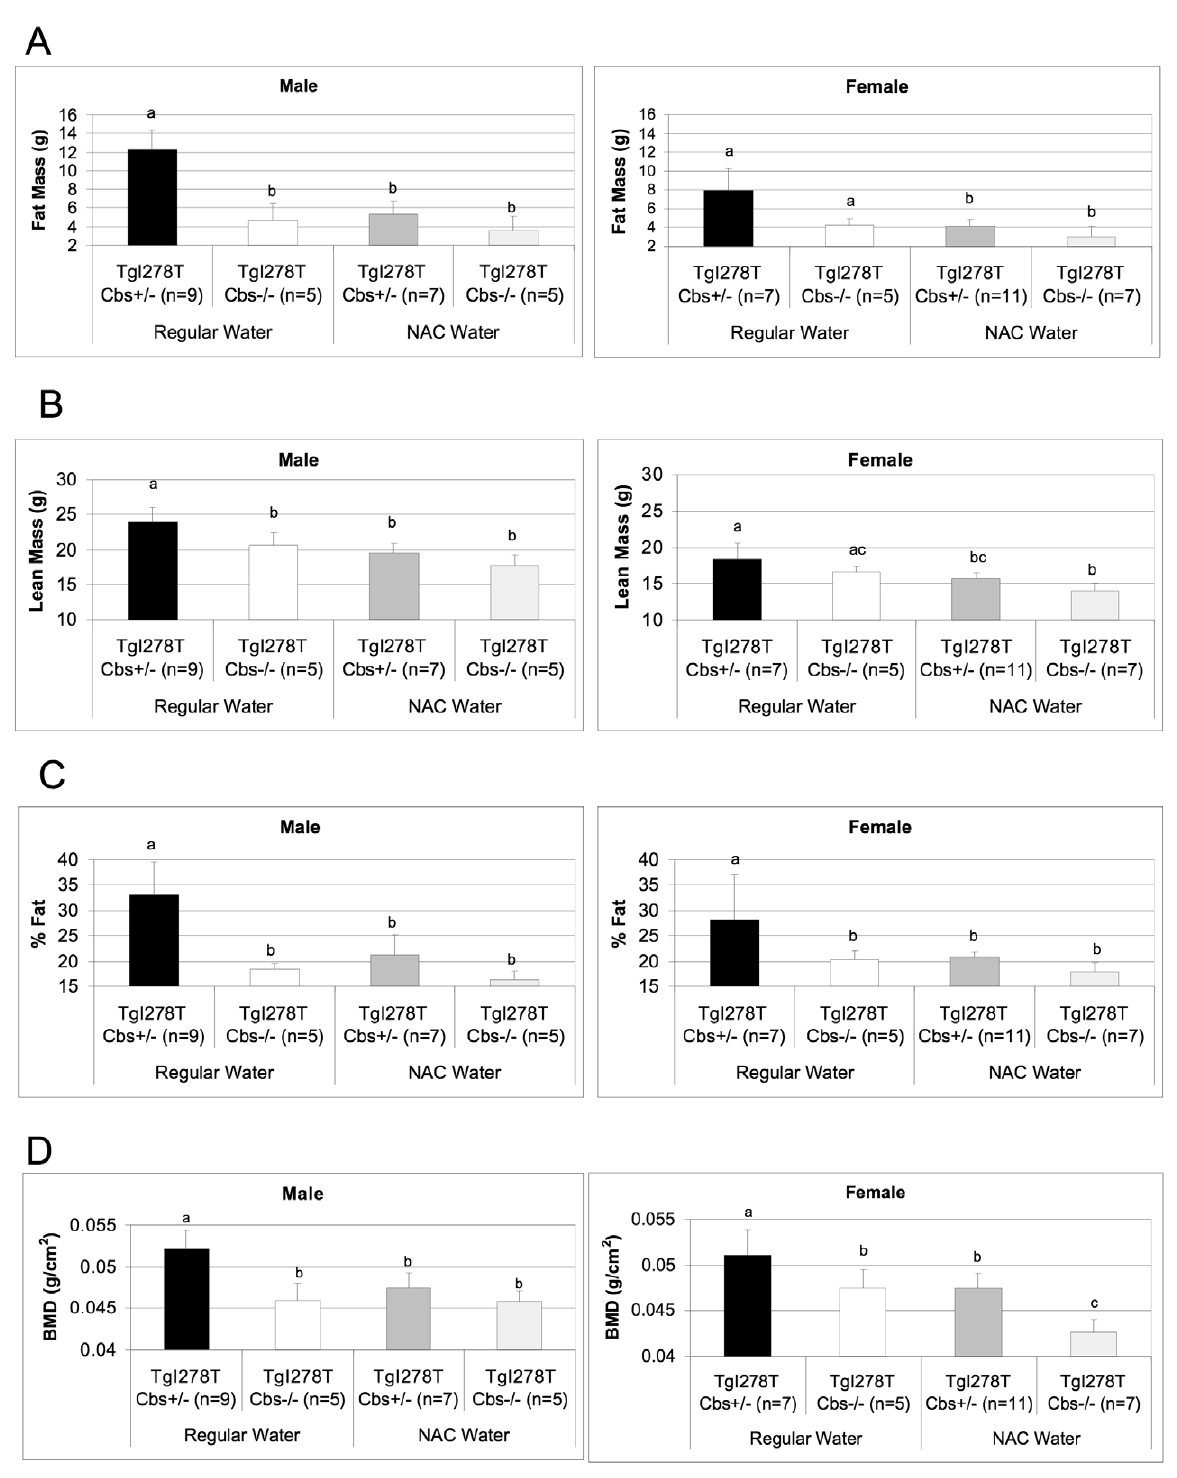
Figure 3. DEXA body composition studies on 240 day old TgI278TCbs 2 / 2 and TgI278TCbs + / 2 mice on regular and NAC supplemented water. All panels show effects on male and female animals separately. ( A ) Effect of genotype and NAC treatment on fat mass. ( B ) Effect of genotype and NAC treatment on lean mass. ( C ) Effect of genotype and NAC treatment on percentage of fat. ( D ) Effect of genotype and NAC on bone mineral density. Significance testing was performed using ANOVA followed by Tukey’s multiple comparison test. All graphs show mean 6 SD. Significant difference between columns are indicated by having a different letter at the top of the error bar. In case of more than two letters, even a single common letter at the top of the bar indicates non-significance.